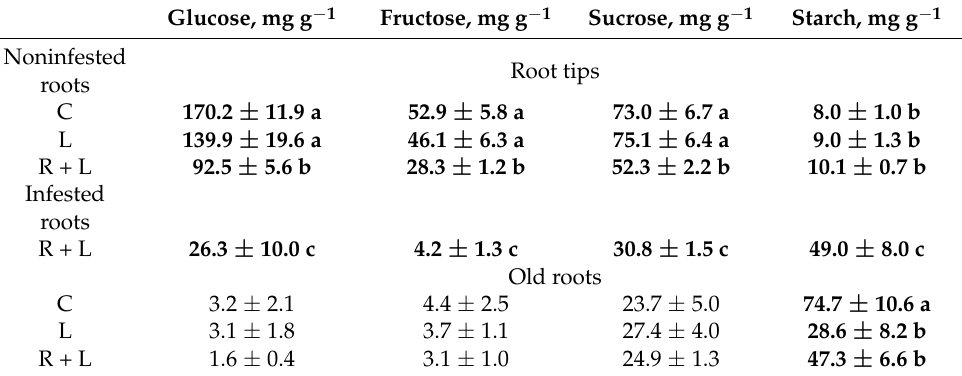
Table 2. Glucose, fructose, sucrose and starch measured in belowground organs sampled from control (C), leaf (L), and both root and leaf infested (R + L) plants 56 days after inoculation. Different letters (and bold) denote significant differences within the groups root tips and old roots (one-way